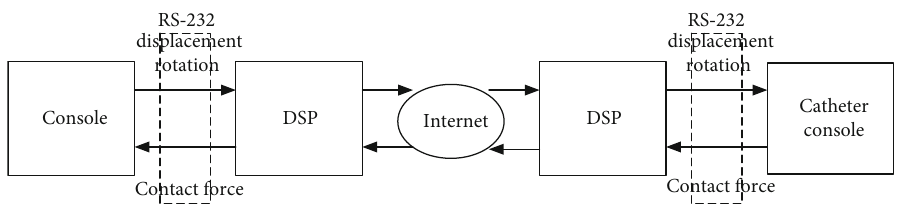
Figure 2: The communication